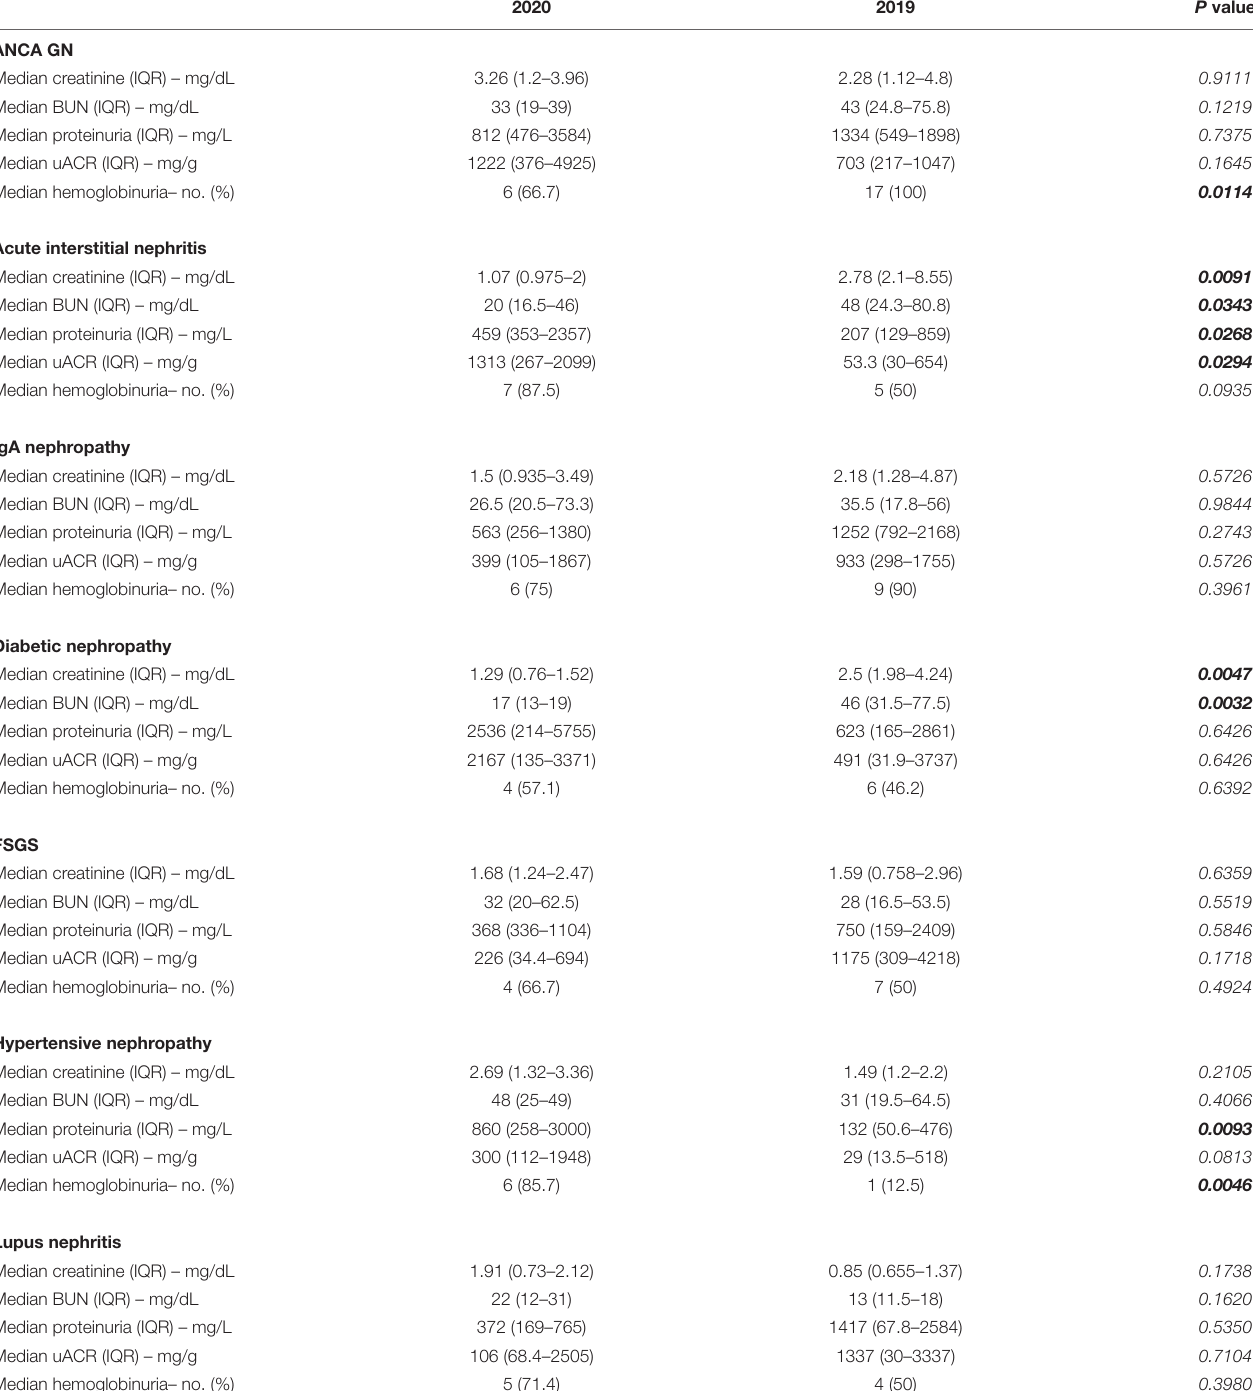
TABLE 4 | Laboratory findings at admission in kidney diseases based on renal biopsies comparing 2020 with